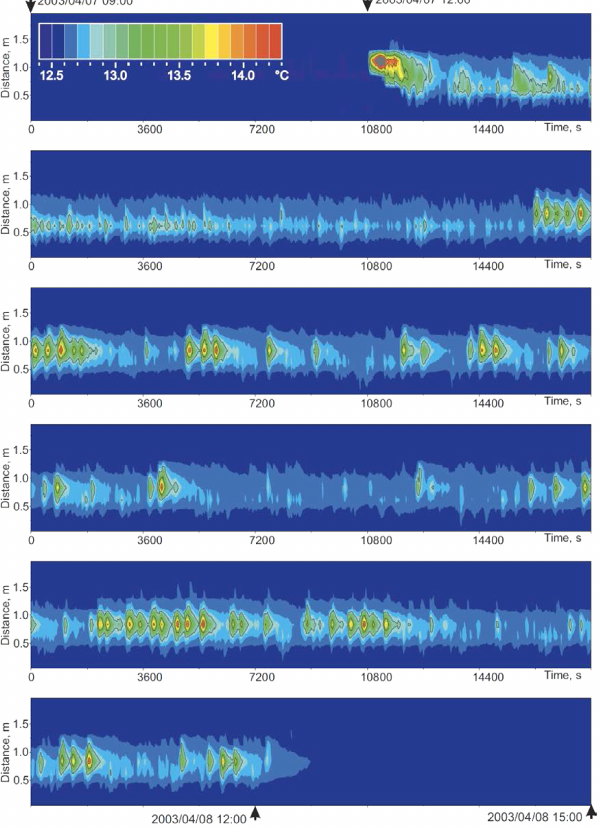
12.513.0 12.513.0 Figure 6. The temperatures in ◦ C at 1.5m height 1h before, during, Figure 6: The temperatures in C° at 1.5-meter height 1 hour before, during, and 2 hours after the A7a experiment. T1, and 2h after the A7a experiment. T1–T10 denote temperature series T2, … , T10 denote temperature series of the ten sensors on the AIII set-up. of the 10 sensors on the AIII setup.